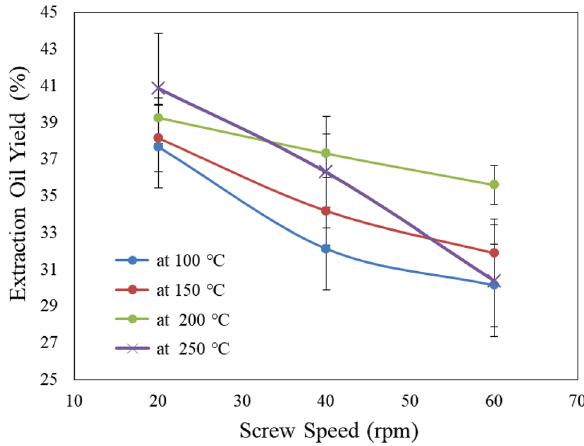
Figure 5. Effect of extraction screw speed and temperature on oil extraction yield castor.